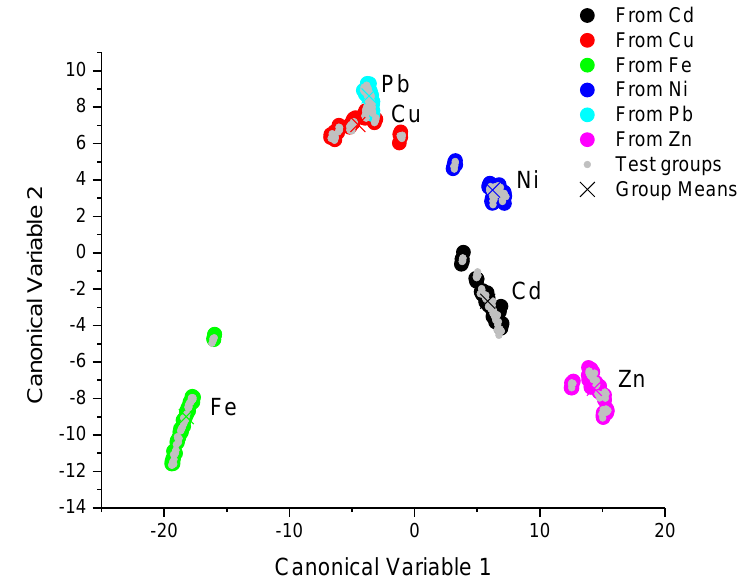
Figure 5. The canonical score plots for the training and testing processes built from the set of spectra data which were obtained with a portable colorimetric system based in multispectral sensors. The classification procedure was obtained by using linear discriminant analyses. Table 4. Classification counts and error rates of different metallic ions obtained after processing and analyzing the fitted parameter of transmittance spectra (obtained with UV-VIS spectrometer) by the linear discriminant analysis